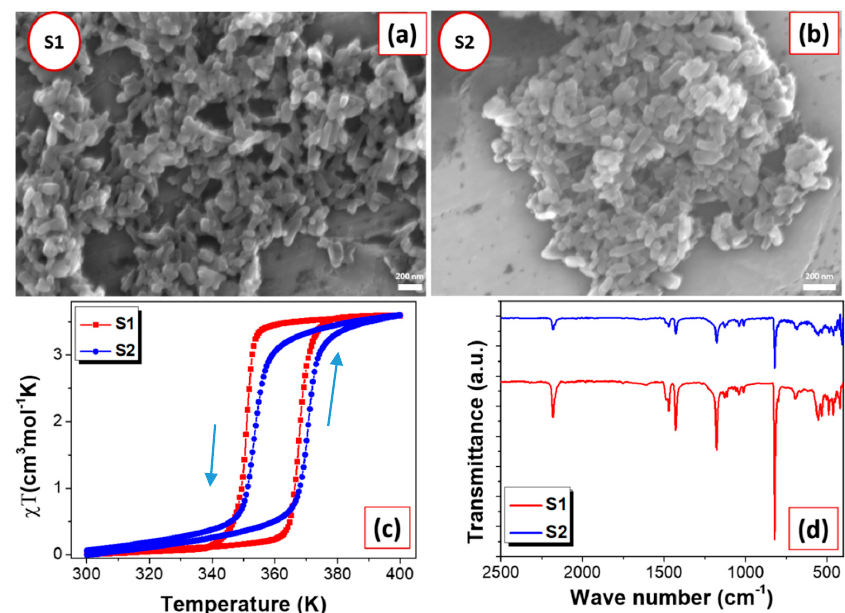
Figure 1. Sample characterization: ( a,b ) SEM micrographs, ( c ) temperature dependence of the magnetic susceptibility × temperature product on heating and cooling, and ( d ) FTIR spectra of samples S1 and S2 .